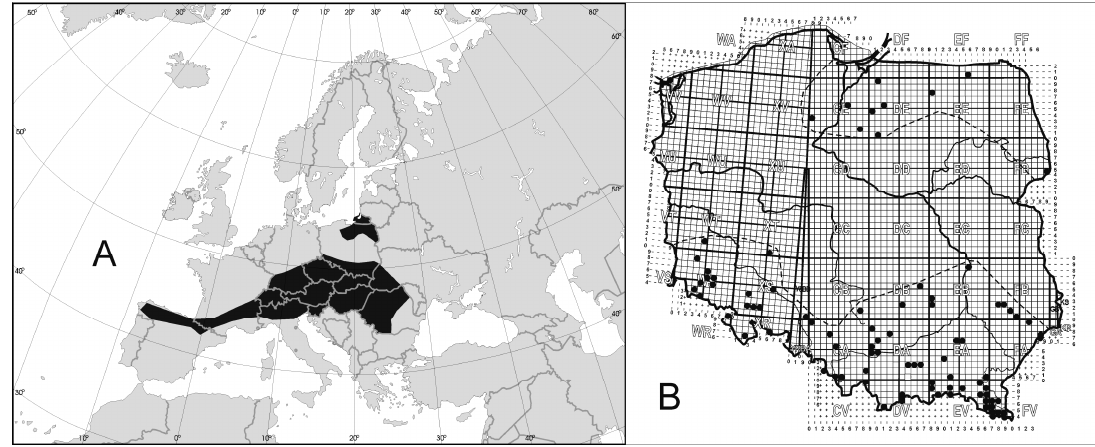
Figure 4. Range of Neodiscopoma splendida : ( A ) in Europe, ( B ) in Poland; black dots—recorded occurrences of the species, dotted line—occurrence range of southern and northern